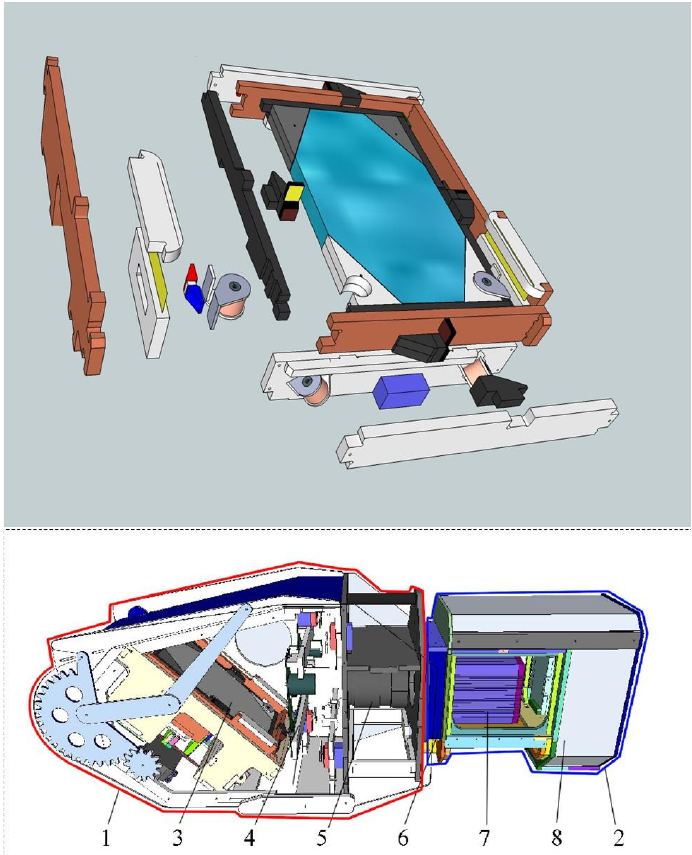
Figure 2. Top panel —celostate mirror frame components. Bottom panel —a scheme of the optical channel of MMT-9: 1. Unit of celostate mirror and filters. 2. Light receiver. 3. Mirror of the celostate block. 4. Block of filters. 5. Lens. 6. Flange for fastening the chamber block. 7. Light detector. 8. Commutation compartment.